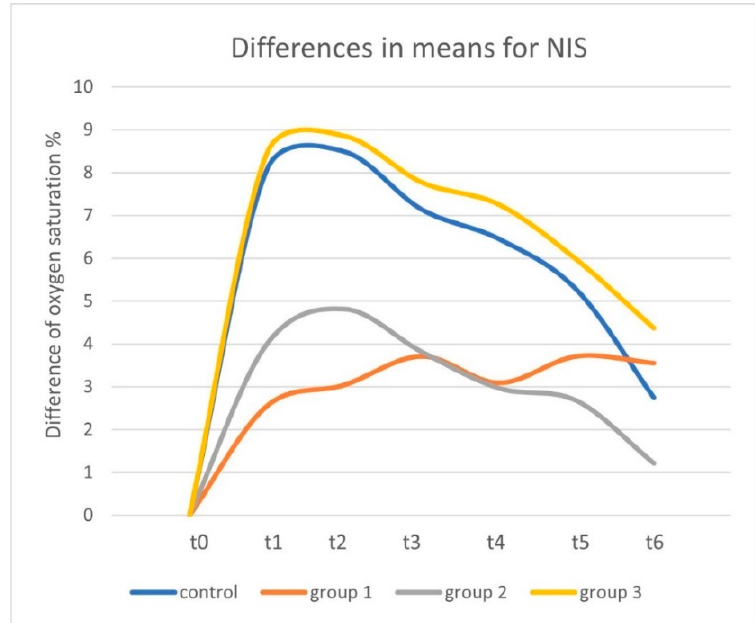
Figure 3. Differences of the means in the oxygen saturation compared to t0 over study timeline for near-infrared spectroscopy images.